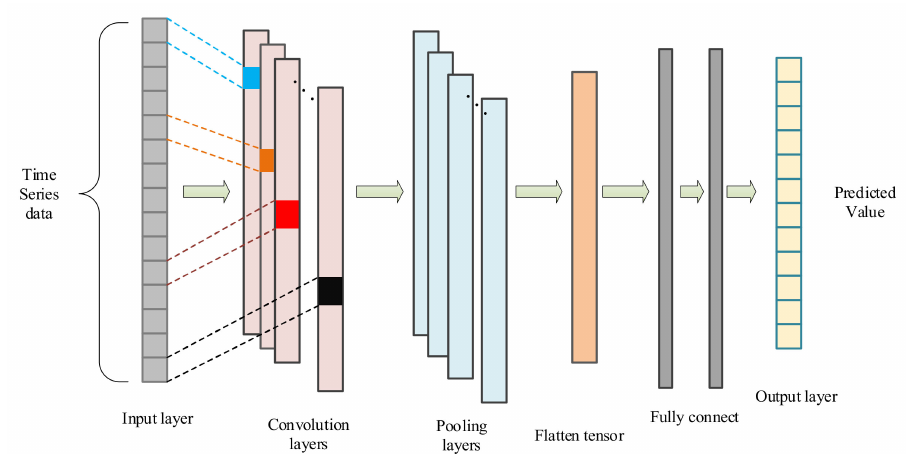
Figure 2. Schematic diagram of basic convolutional neural